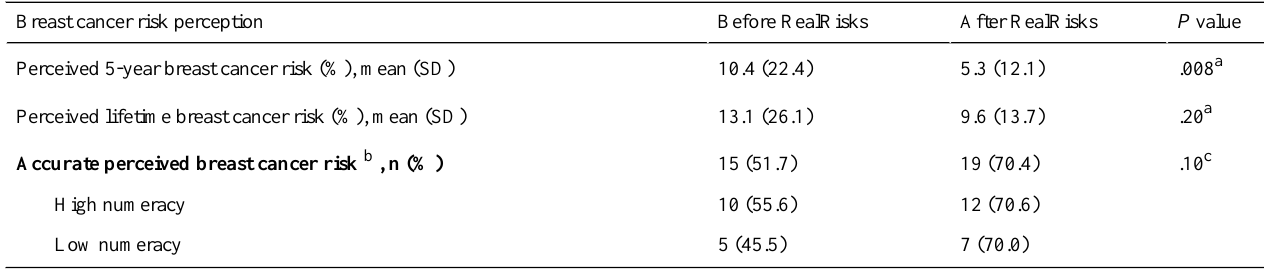
Table 2. Accuracy of breast cancer risk perceptions before and after interacting with the RealRisks decision aid among focus group participants (N = 34), New York City (2013).